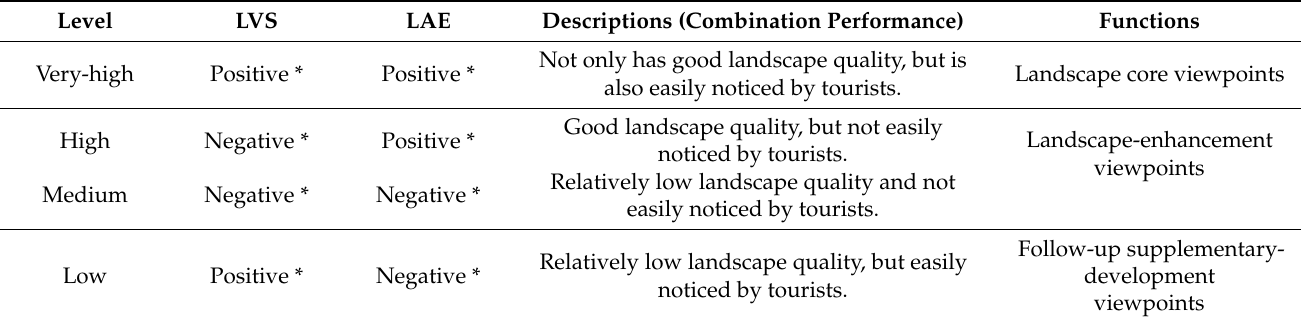
Table 7. The combination performance of LVS and LAE.